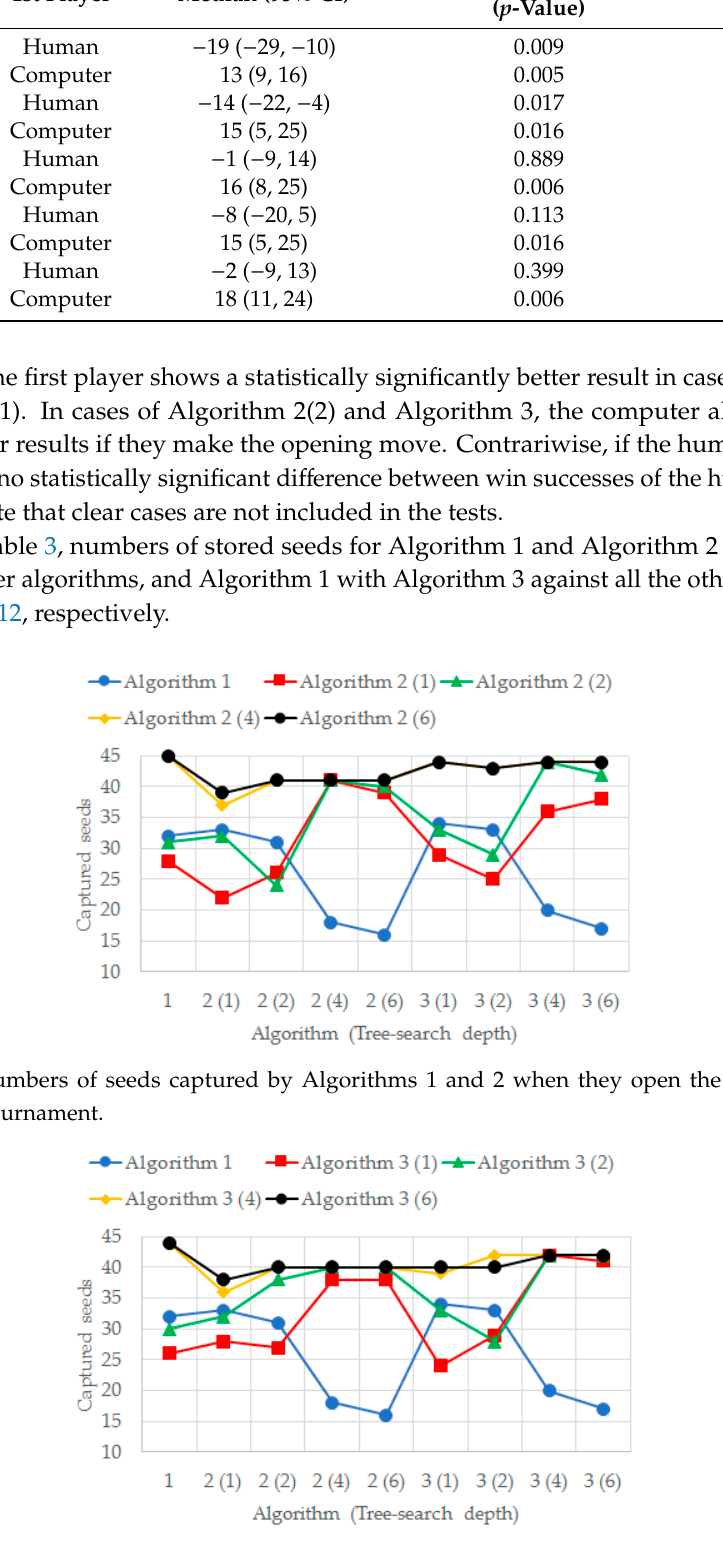
Figure 12. Numbers of seeds captured by Algorithm 1 and Algorithm 3 when they open the game in the round-robin tournament.